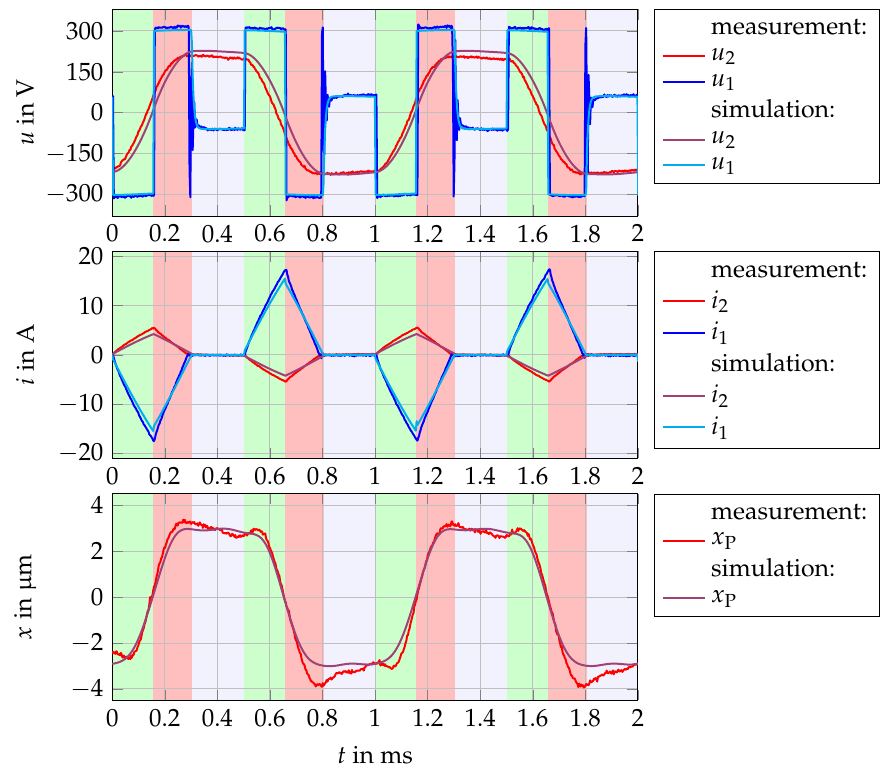
Figure 12. Measured signals compared to simulated values for an excitation frequency of 1000Hz.